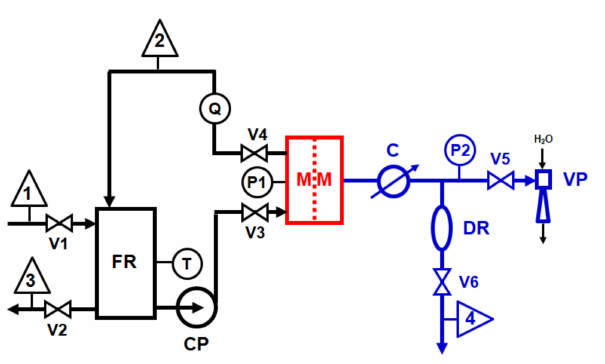
Figure 1. Laboratory-scale VMD plant scheme: 1 = feed inlet; 2 = concentrate outlet (recycled); 3 = feed outlet; 4 distillate outlet (recycled).